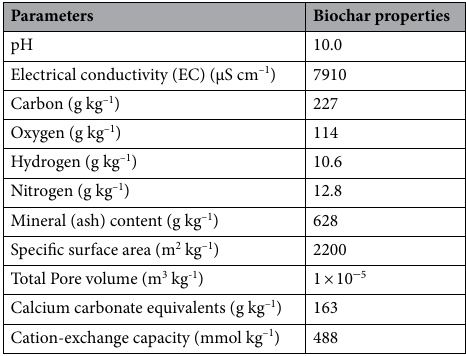
Table 2. Physical and chemical characteristics of cattle manure biochar used in the pot experiments (on a dry weight basis). Reproduced with permission from Kumar, et al. 47